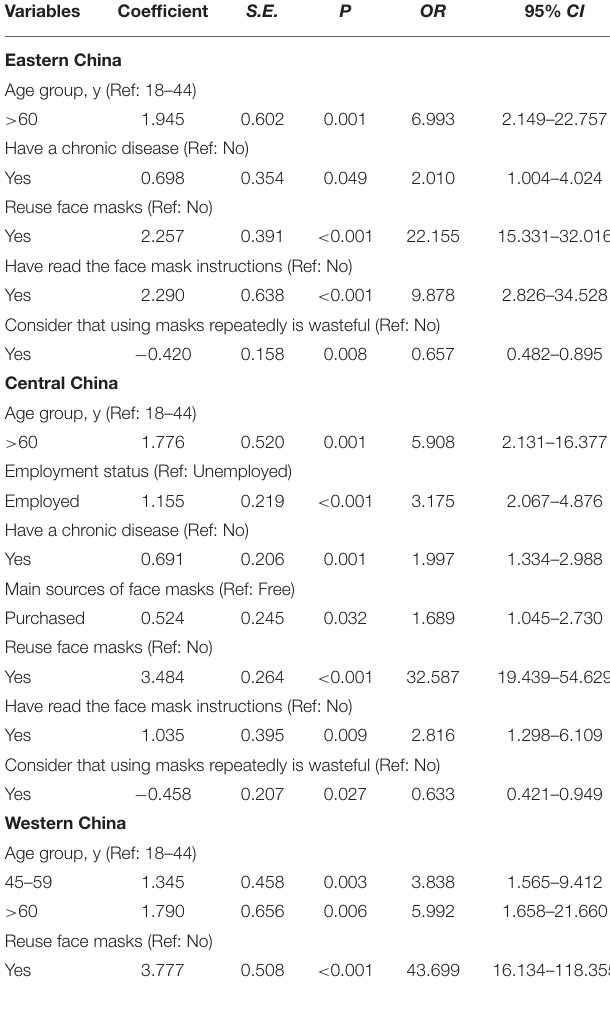
communication during the Spring